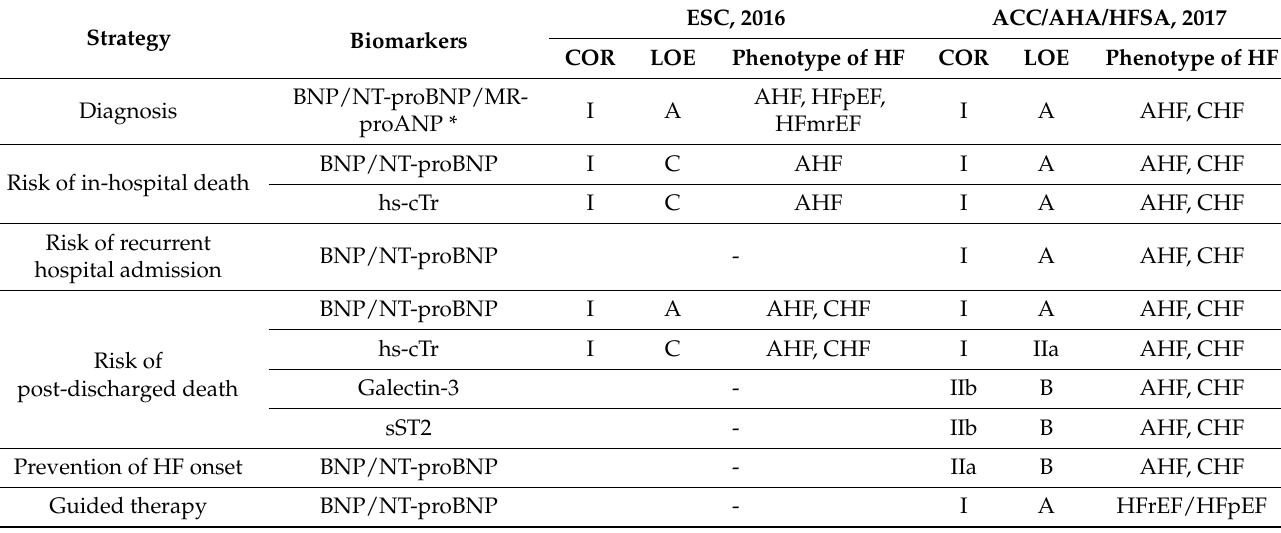
Table 1. 2016 ESC and 2017 ACC/AHA/HFSA recommendations for the use of biomarkers in the management of